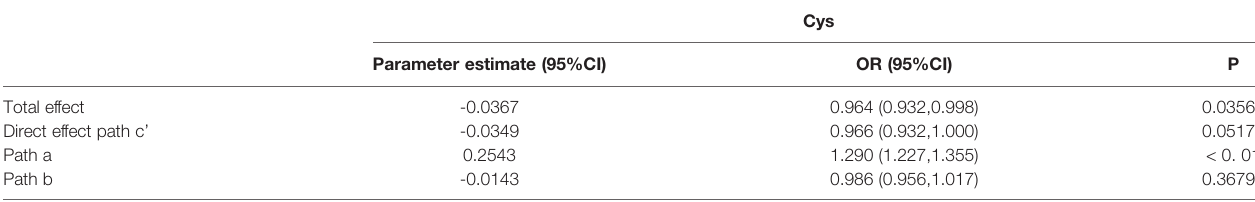
TABLE 5 | Mediation analysis of the relationship between Hcy and DR by Cys.